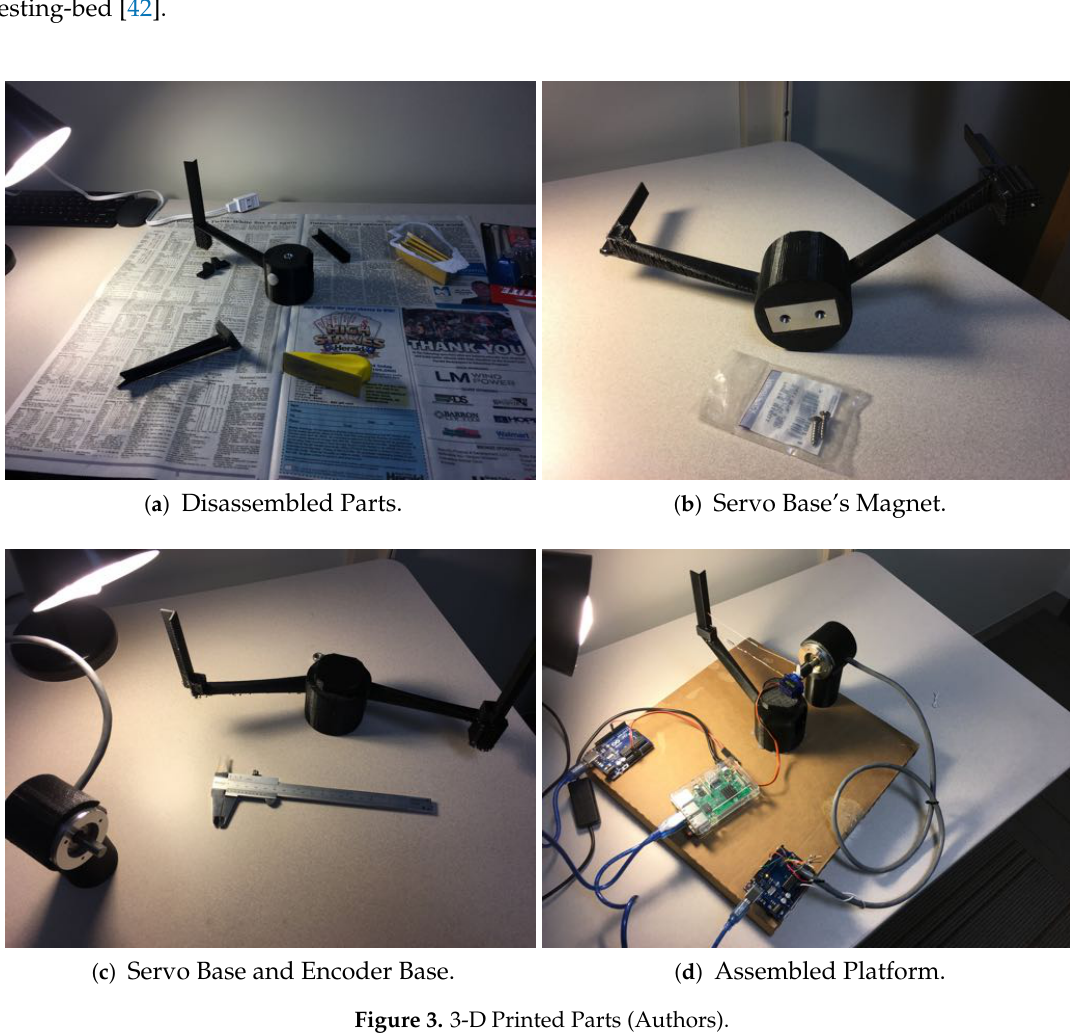
Figure 3. 3-D Printed Parts